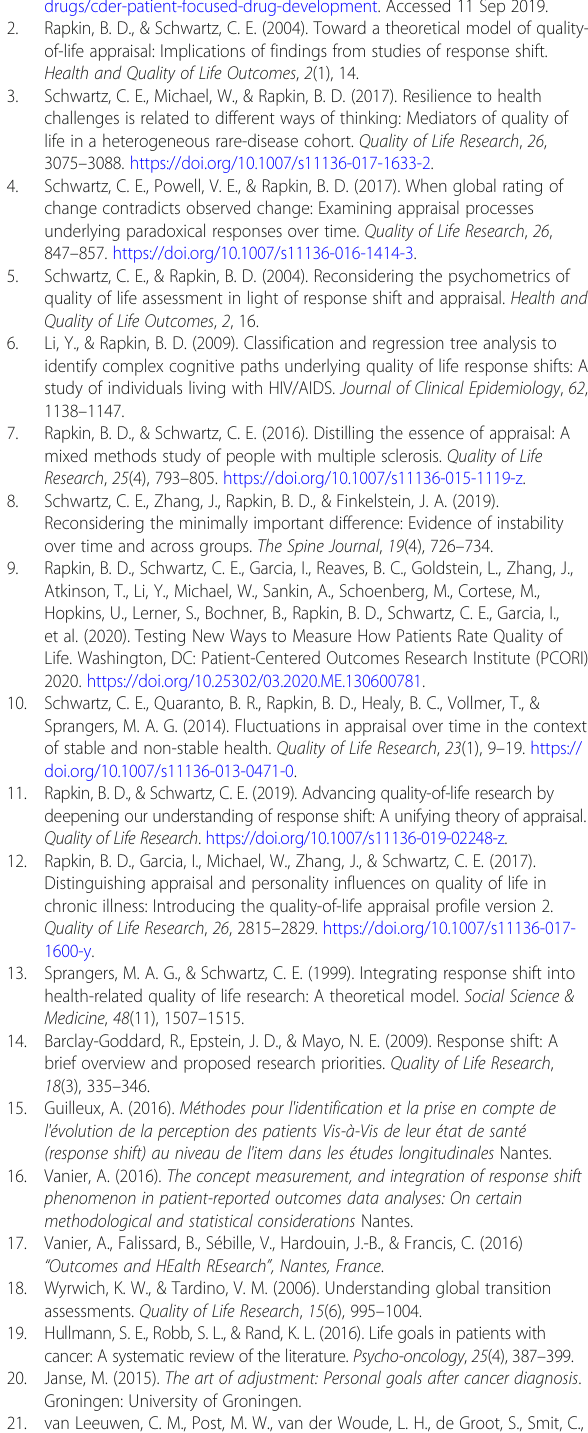
Additional file 2: Supplemental Figure 1. Effect and causal indicators of quality-of-life. Standard psychometric techniques are appropriate for validating effect indicators (i.e., reflective measurement model), which re- flect changes in quality of life. In contrast, causal indicators, which cause changes in quality of life (i.e., formative measurement model), would be validated using clinimetric or idiometric methods, depending on the na- ture of the construct being